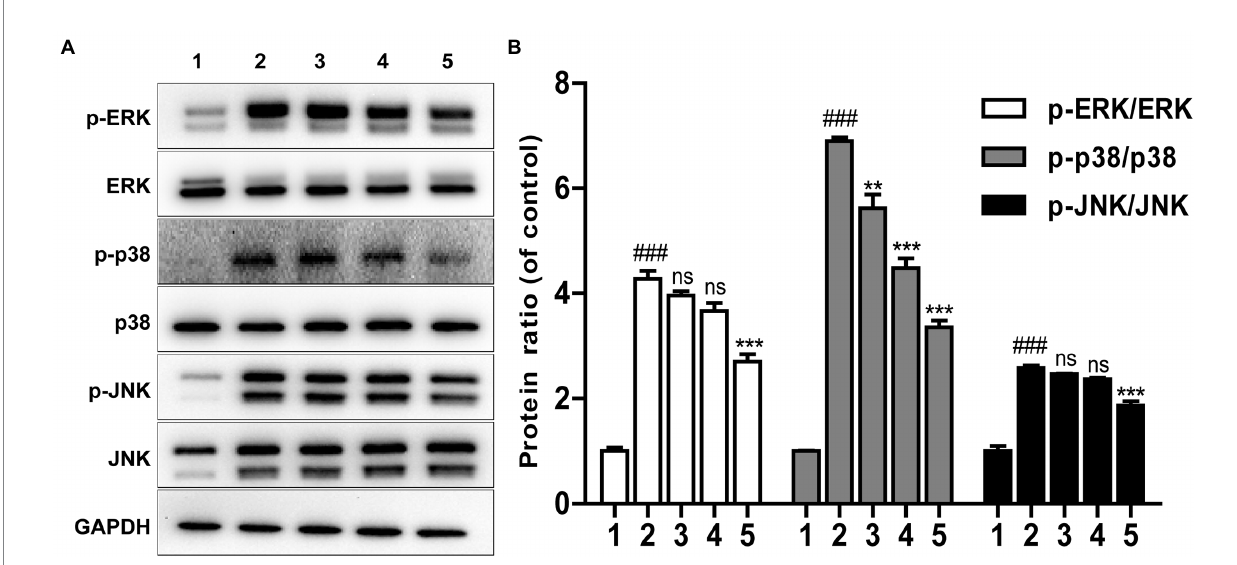
FIGURE 4 Effects of Brevinin-1GHd on inflammatory pathway activation inspired by LPS. (A) Typical WB bands of ERK, p38, JNK in RAW 264.7 cells. The cells were pre-treated with or without 1, 2, and 4 μ M Brevinin-1GHd for 30 min and an additional 30 min after LPS addition, then were collected for WB analysis. ICONS 1–5 are the control group, LPS treatment group, and 100 ng/ml LPS plus 1, 2, and 4 μ M Brevinin-1GHd treatment groups, respectively. (B) Quantification analysis of band densities in A figure. Data are expressed as mean ± SEM ( n = 3). ∗∗ p < 0.01 and ∗∗∗ p < 0.001 as well as ### p < 0.001 suggest significant difference in comparison with the control incubated with 100 ng/ml LPS and with the control without both LPS and Brevinin-1GHd,